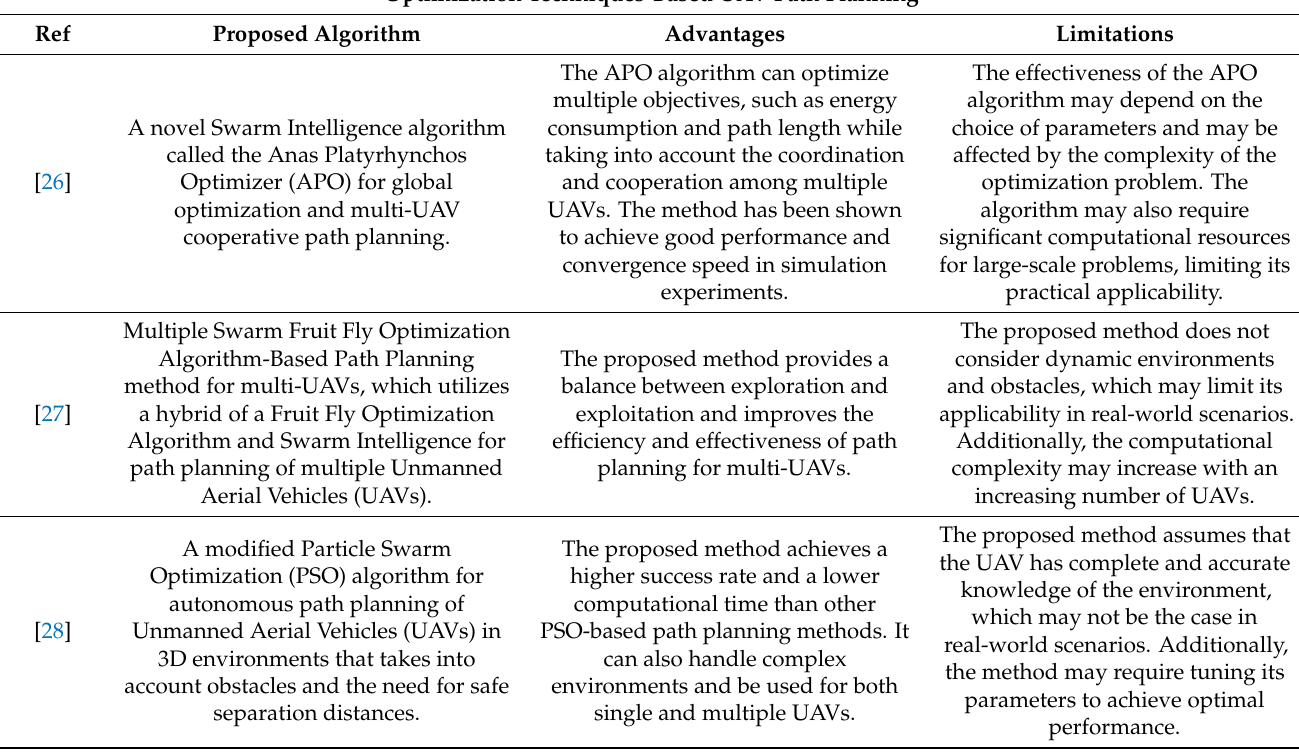
Table 2. A detailed study of UAV path planning using Optimization Techniques-based UAV Path